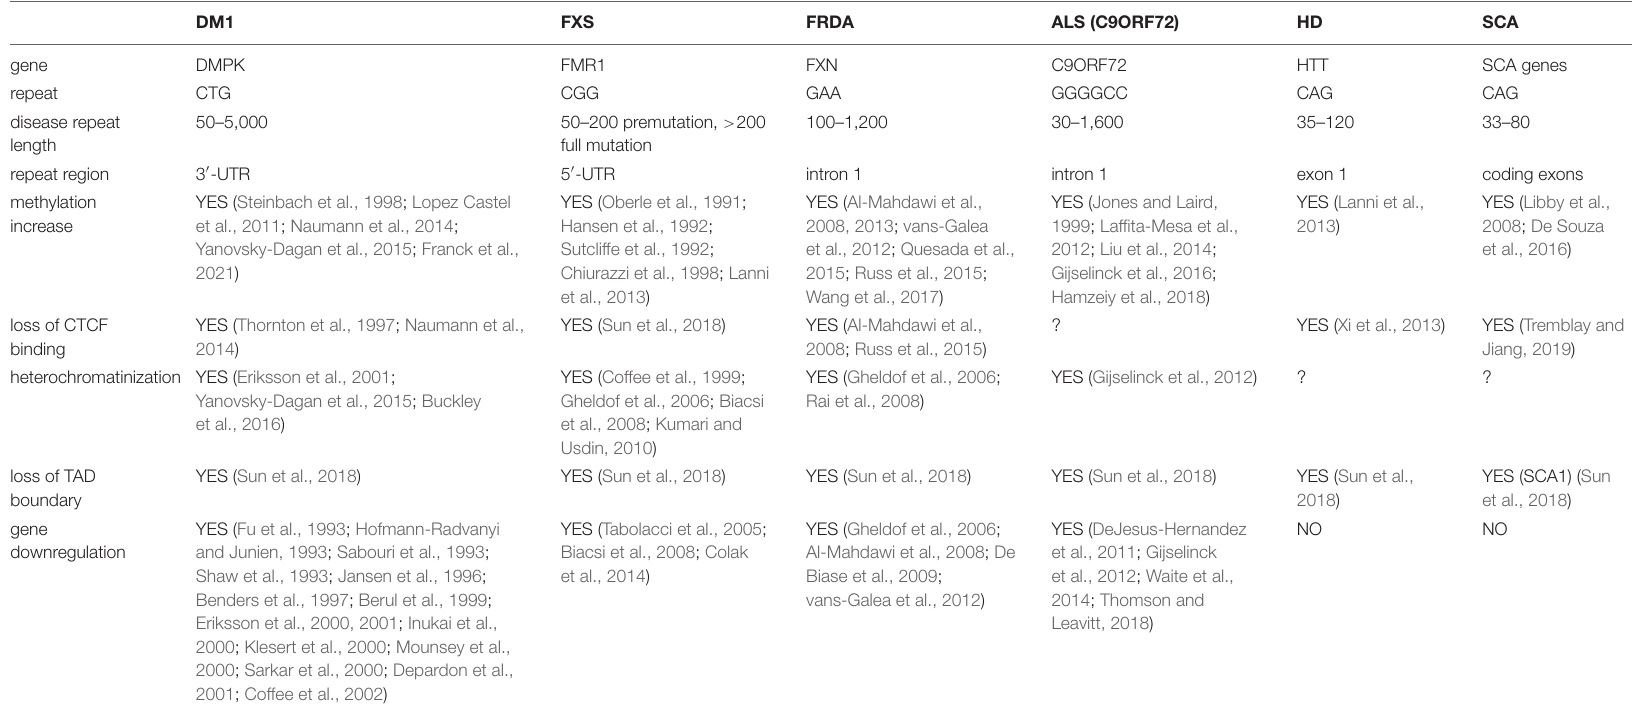
TABLE 1 | A comparison of repeat diseases with different genetic characteristics shows a common epigenetic signature.